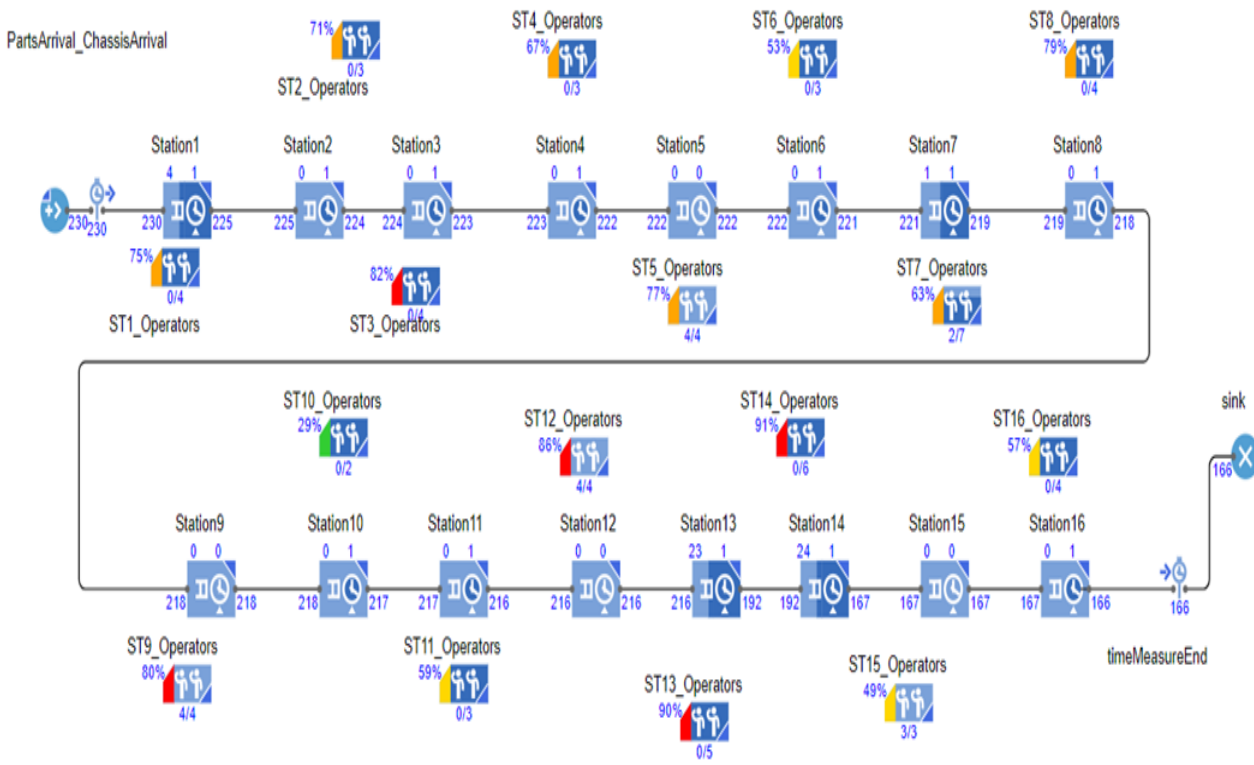
Figure 3. Simulated production system for the truck manufacturing industry.